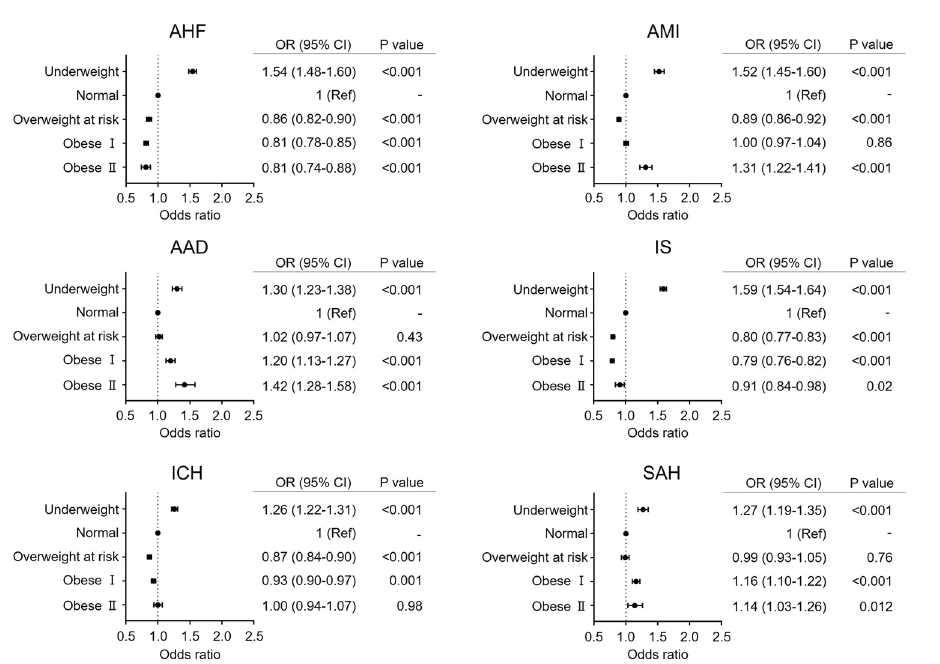
Figure 3. Impact of BMI on in-hospital mortality in each cardiovascular disease (CVD) group: model 1. Age and sex were simultaneously entered into a multivariable logistic regression model to investigate the impact of BMI on in-hospital mortality. Only odds ratios (ORs) and 95% confidence intervals (CIs) of each BMI category are shown. AAD acute aortic dissection, AHF acute heart failure, AMI acute myocardial infarction, BMI body mass index, CI confidence interval, ICH intracerebral hemorrhage, IS ischemic stroke, OR odds ratio, SAH subarachnoid